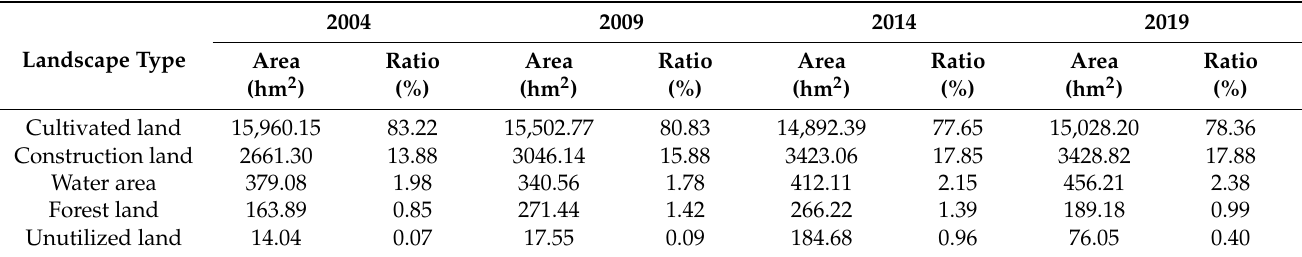
Table 3. Composition changes of landscape types during